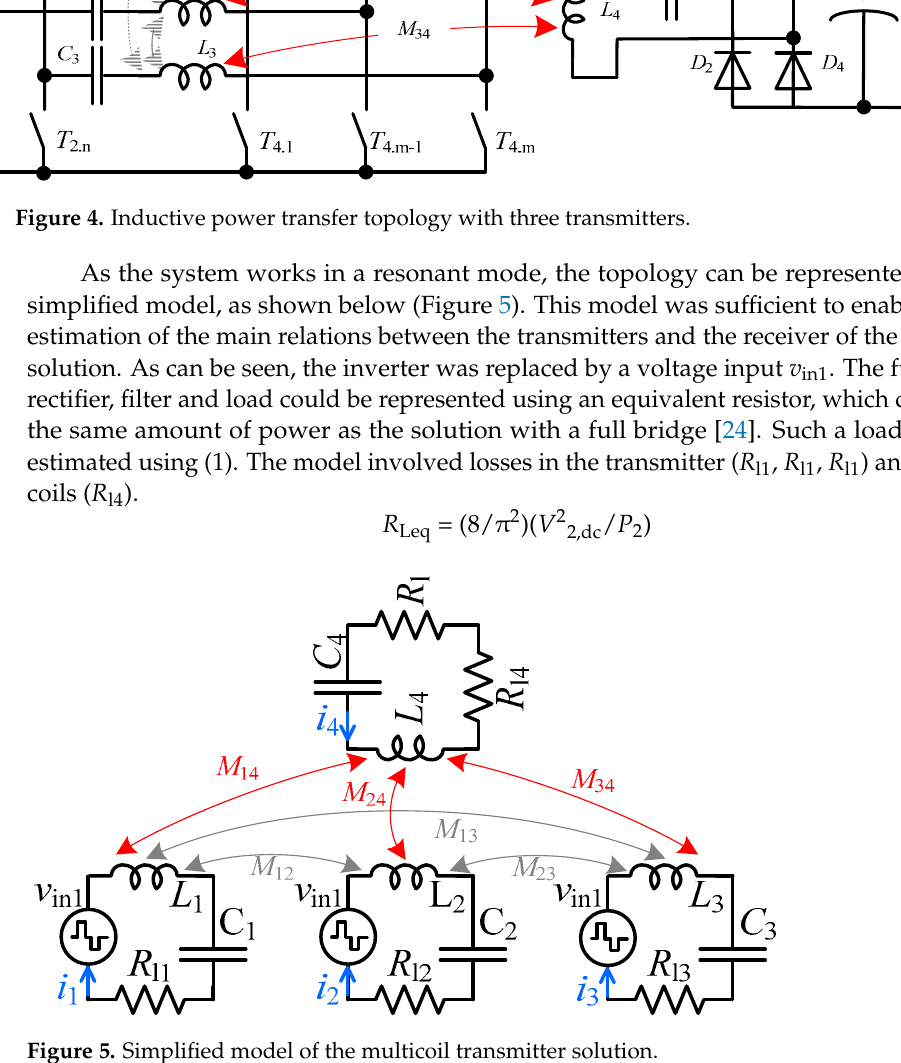
Figure 5. Simplified model of the multicoil transmitter solution. 2.2. State Space Model of the Power Transmitter Link Based on the simplified topology model, a wireless transmitting system could be rep- resented using an eighth-order system of differential Equations (2).